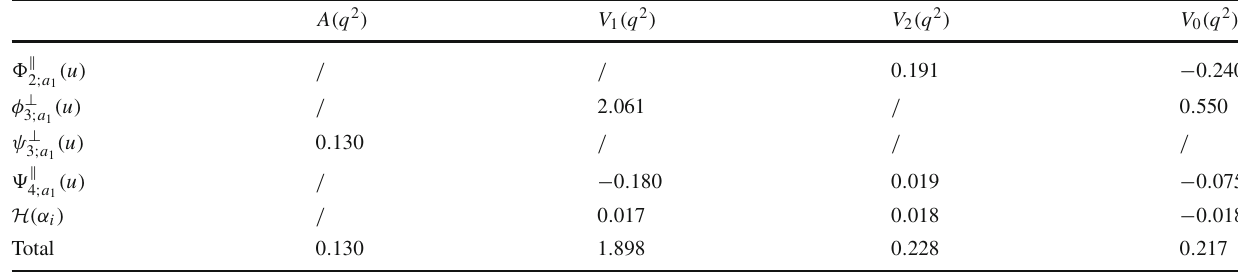
Table 4 The D → a 1 ( 1260 ) TFFs at the large recoil region q 2 = 0, in which the twist-2,3,4 LCDAs’ contributions are presented separately